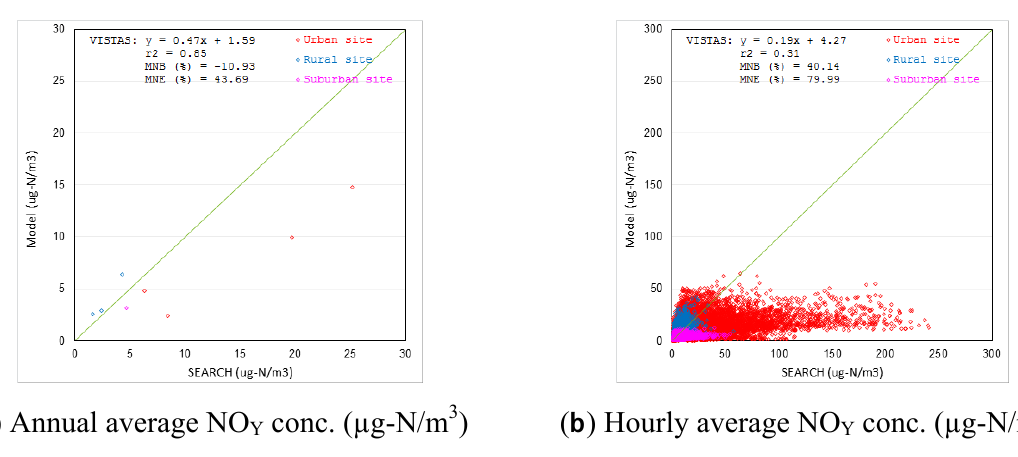
wet depositions 4